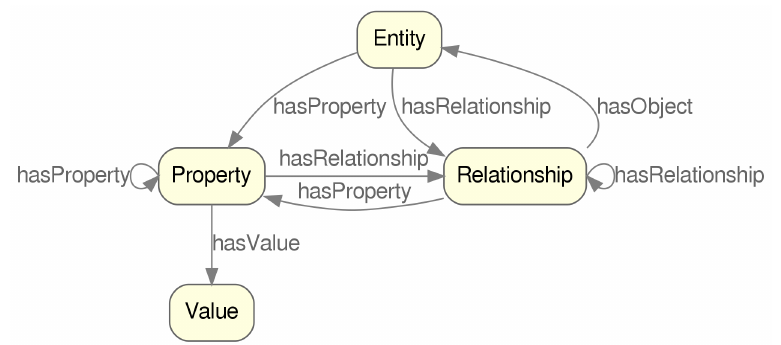
Figure 10. Main concepts of the NGSI-LD ontology.